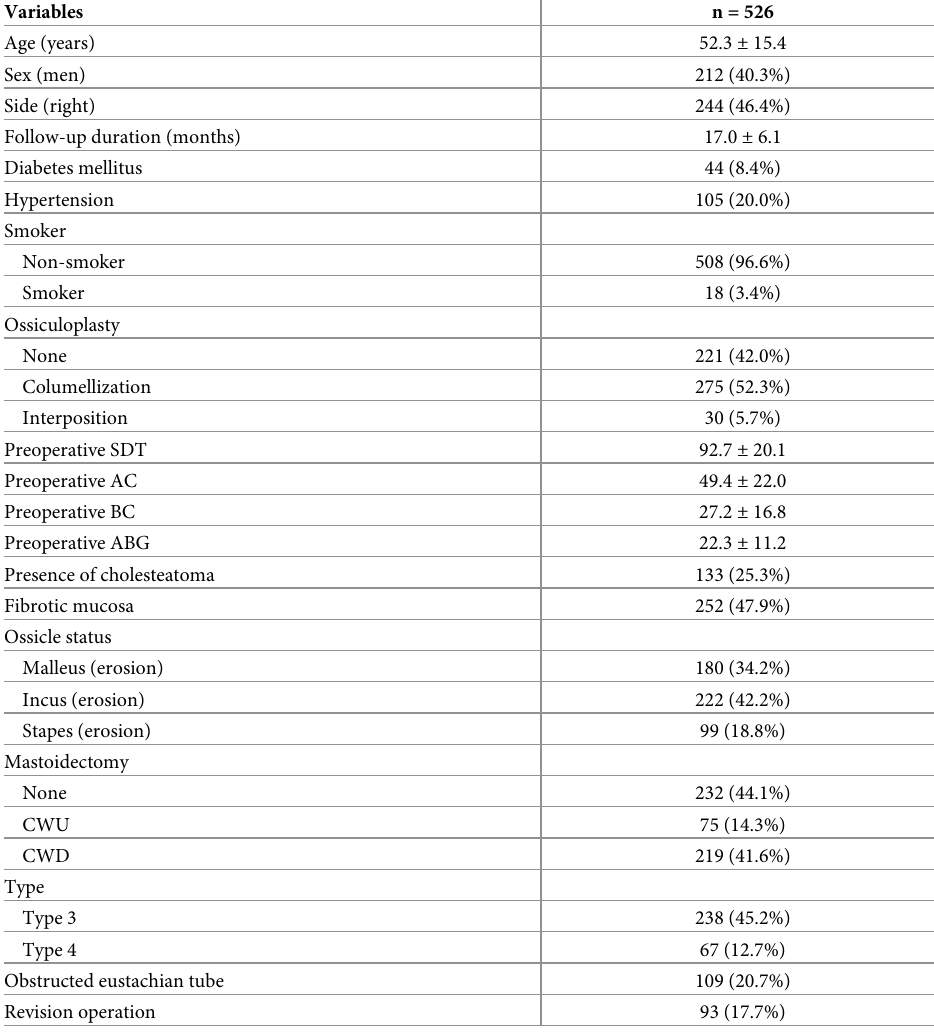
Table 1. Baseline